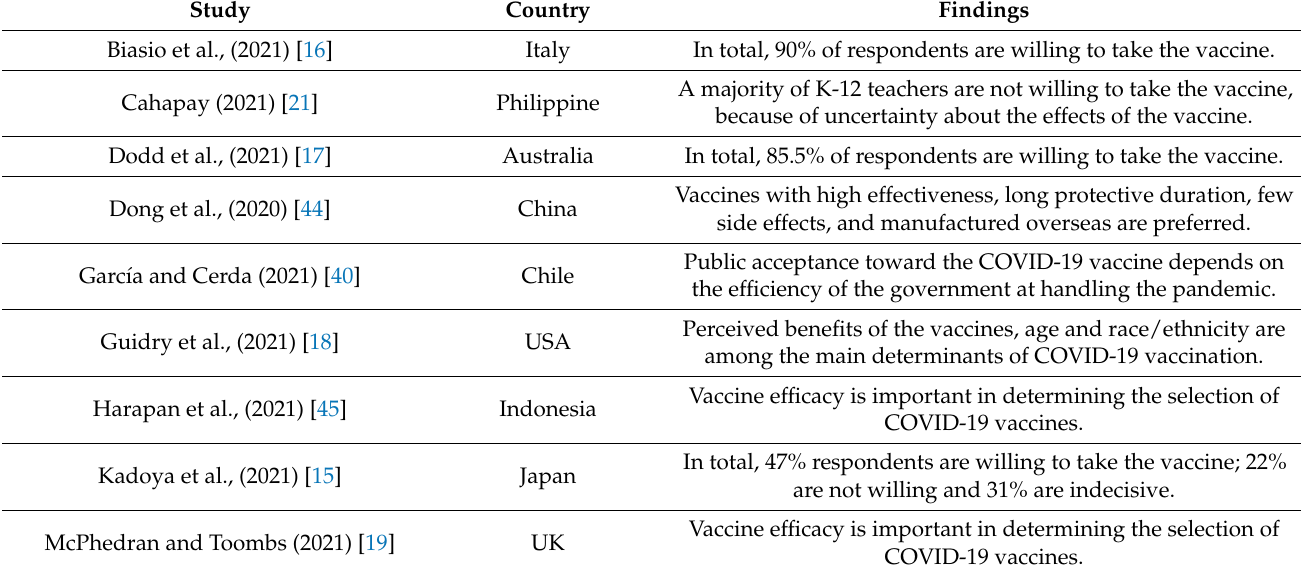
Table 1. Summary of the literature on the COVID-19 vaccine acceptance